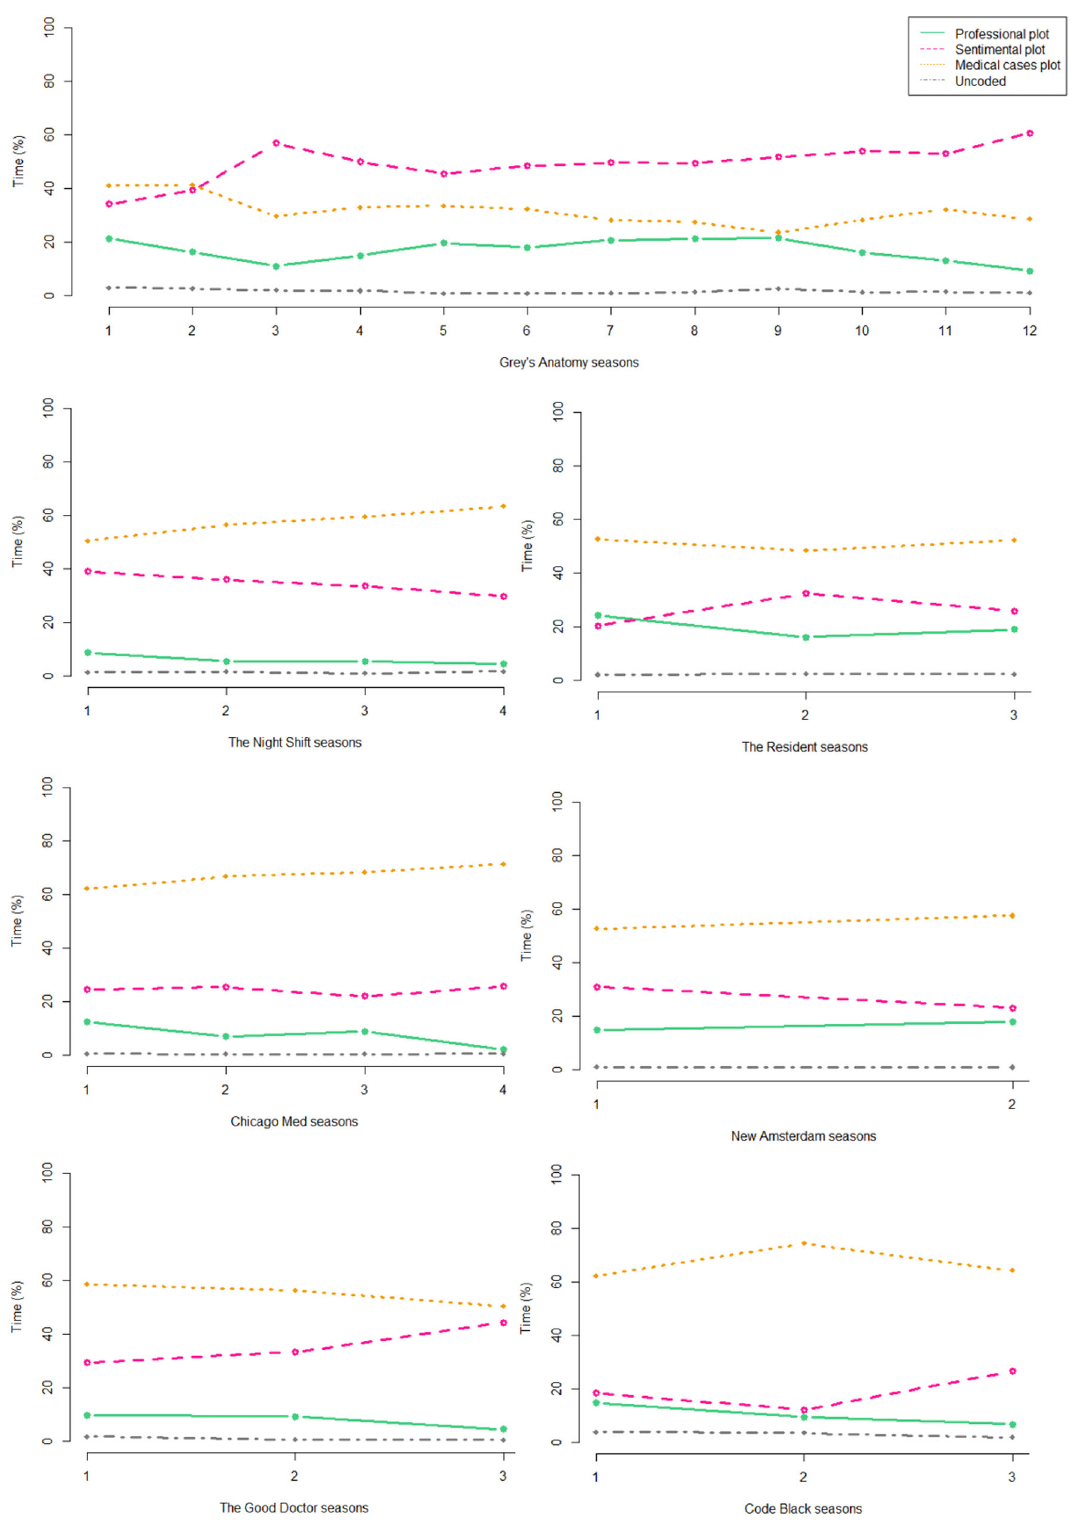
Fig. 4 Evolution of the TV series over time. The fi gure shows the time series of seven series of the corpus ( Miami Medical is not present because it has only one season). The legend at the top right applies to all